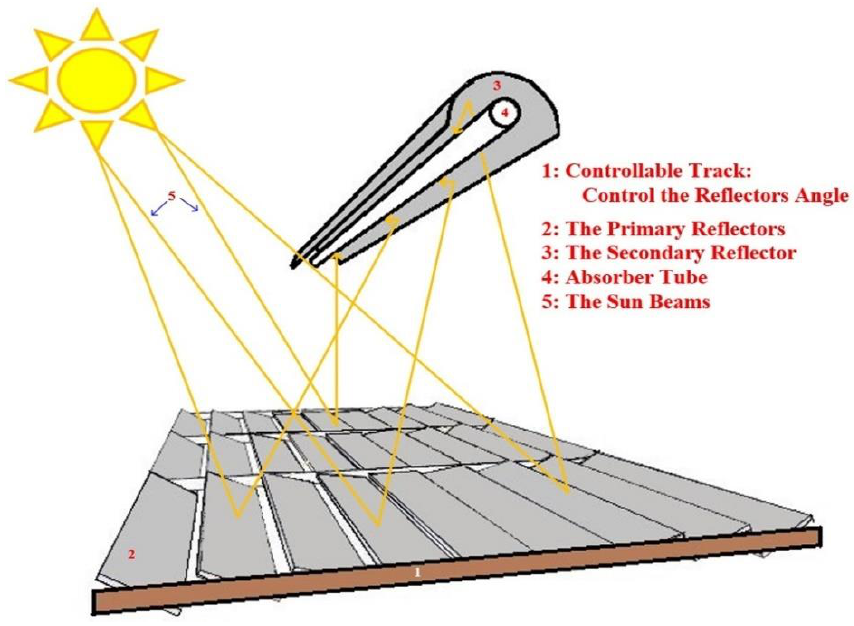
Figure 10. Linear Fresnel reflector